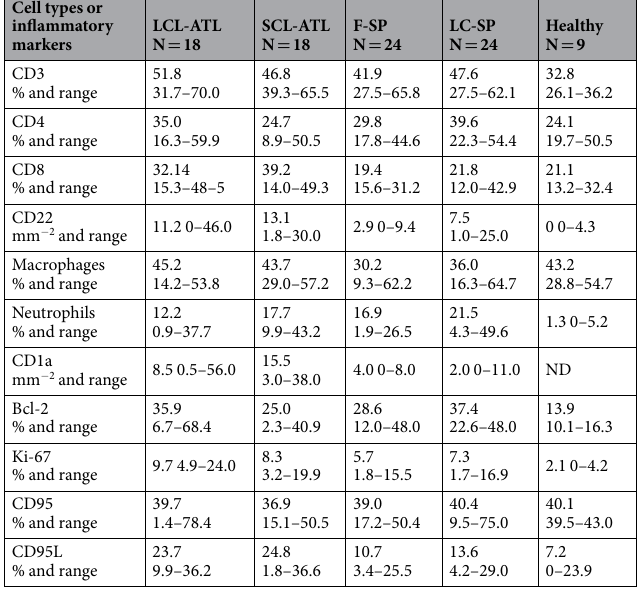
Table 2. Cell types and inflammatory markers in American tegumentary leishmaniasis and sporotrichosis lesions. Data shown as median and range. LCL-ATL a : localized cutaneous leishmaniasis; SCL-ATL b : sporotrichoid cutaneous leishmaniasis; F-SP c : fixed sporotrichosis; LC-SP d : Lymphocutaneous sporotricosis.